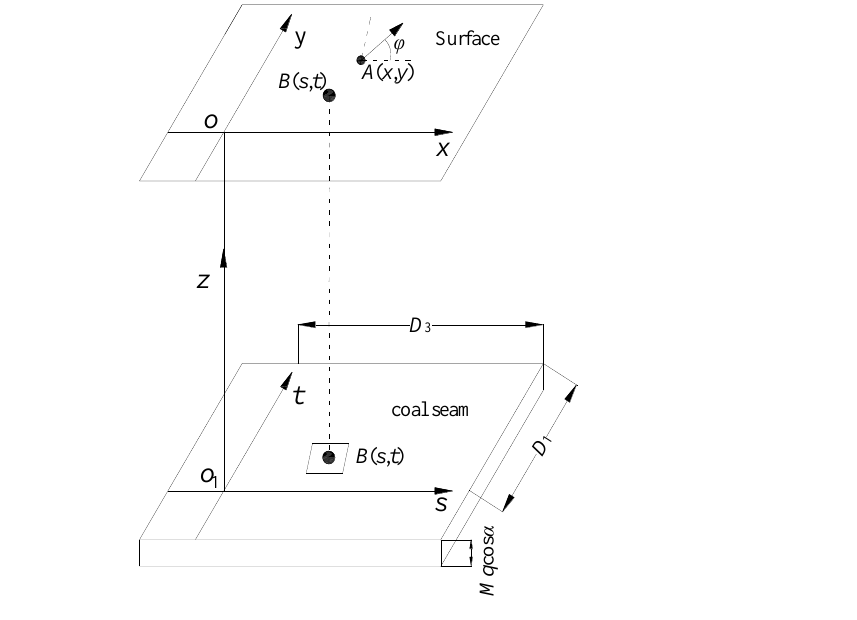
Figure 8. The spatial coordinate system for the subsidence of any point.